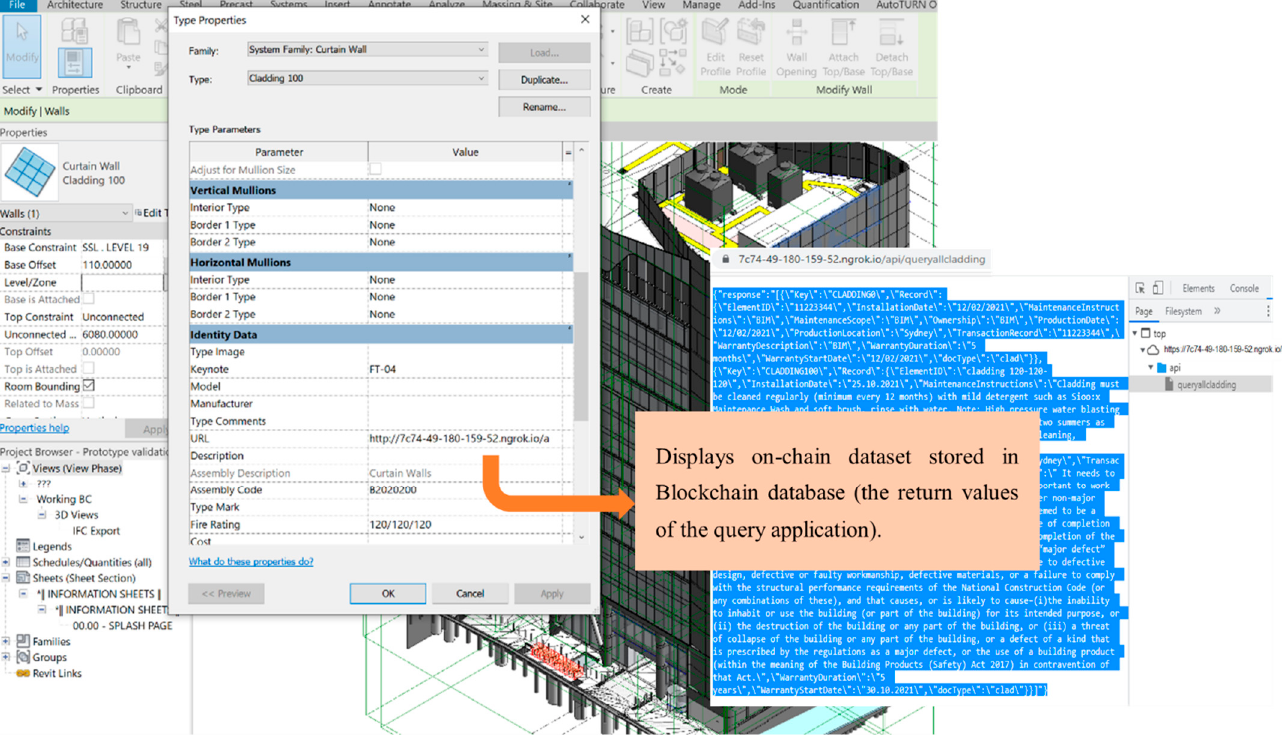
Figure 9. Successful linking of the on-chain dataset (the return values of the query application) to Revit (the BIM platform) and displaying (accessed) its transaction values.